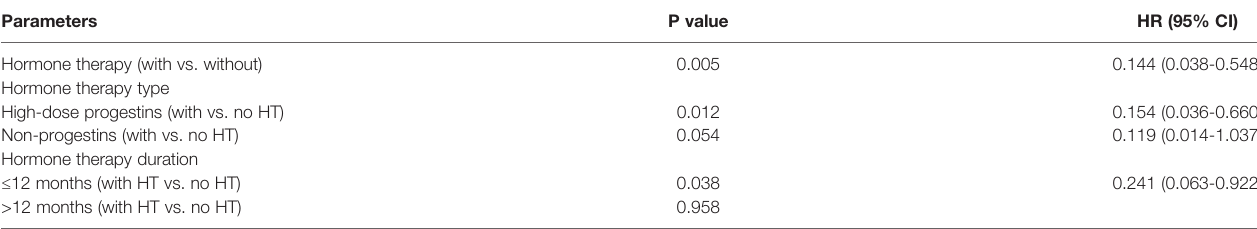
TABLE 3 | Univariate Cox regression of hormone therapy parameters in patients with stage II-IV disease. Parameters Hormone therapy (with vs. without)